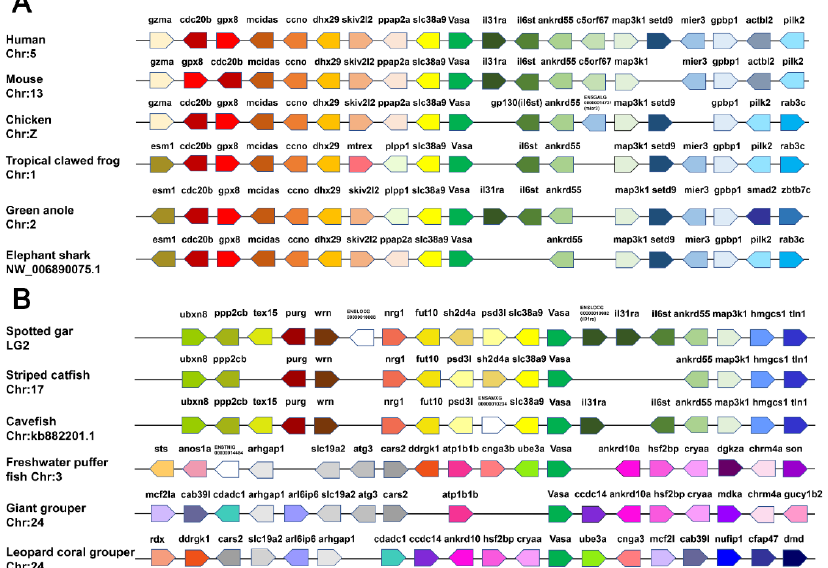
Figure 3. Synteny analyses of vasa genes in vertebrates. ( A ) Chromosomal segments showing the conserved syntenic block around vasa are shown from human, mouse, chicken, tropical clawed frog, green anole and elephant shark. ( B ) The syntenic blocks of vasa in teleosts, including spotted gar, striped catfish, cavefish, freshwater puffer fish, giant grouper and leopard coral grouper ( Plectropomus leopardus ). Different genes are marked with different colored arrows. The direction and position of the arrows indicate the genomic direction and position in the same chromosome or scaffold, respectively, relative to several other genes. The empty spaces indicate regions with the absence of the gene in the genome.